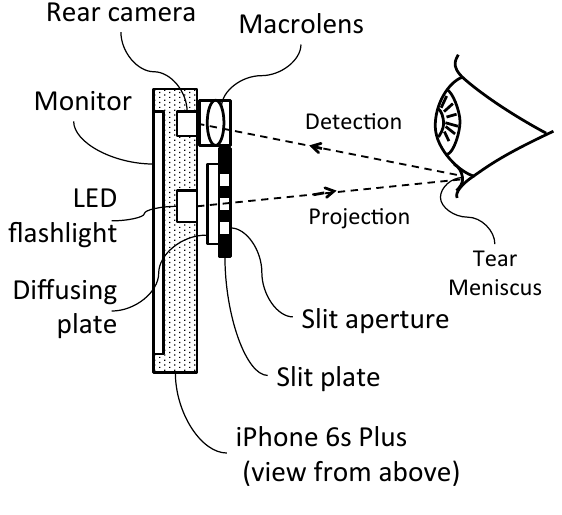
Figure 2. Diagram of the proposed system.